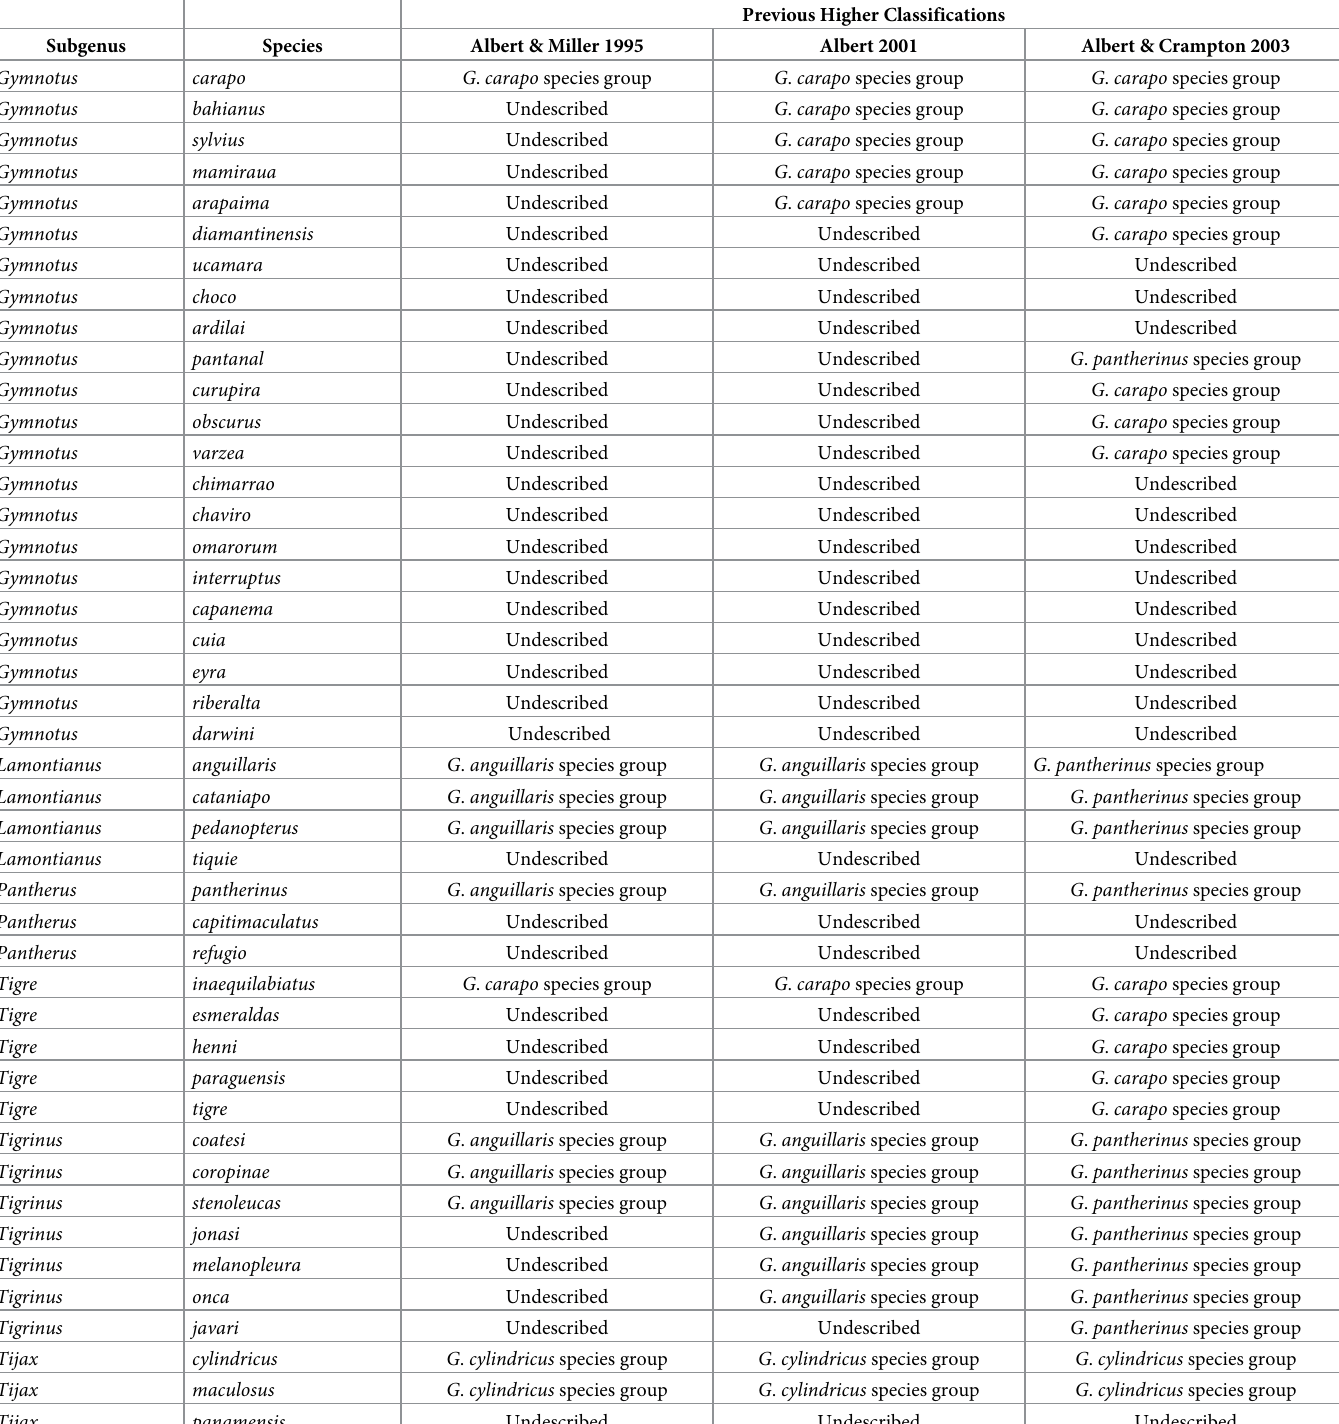
Table 3. List of valid gymnotine species and higher taxa to which each was assigned in three taxonomic revisions from 1995–2003. Species are marked "undescribed" if they had not been described at the time of the study, "not investigated" if they fell outside the scope of that study, and "not grouped" if they were not assigned to a higher